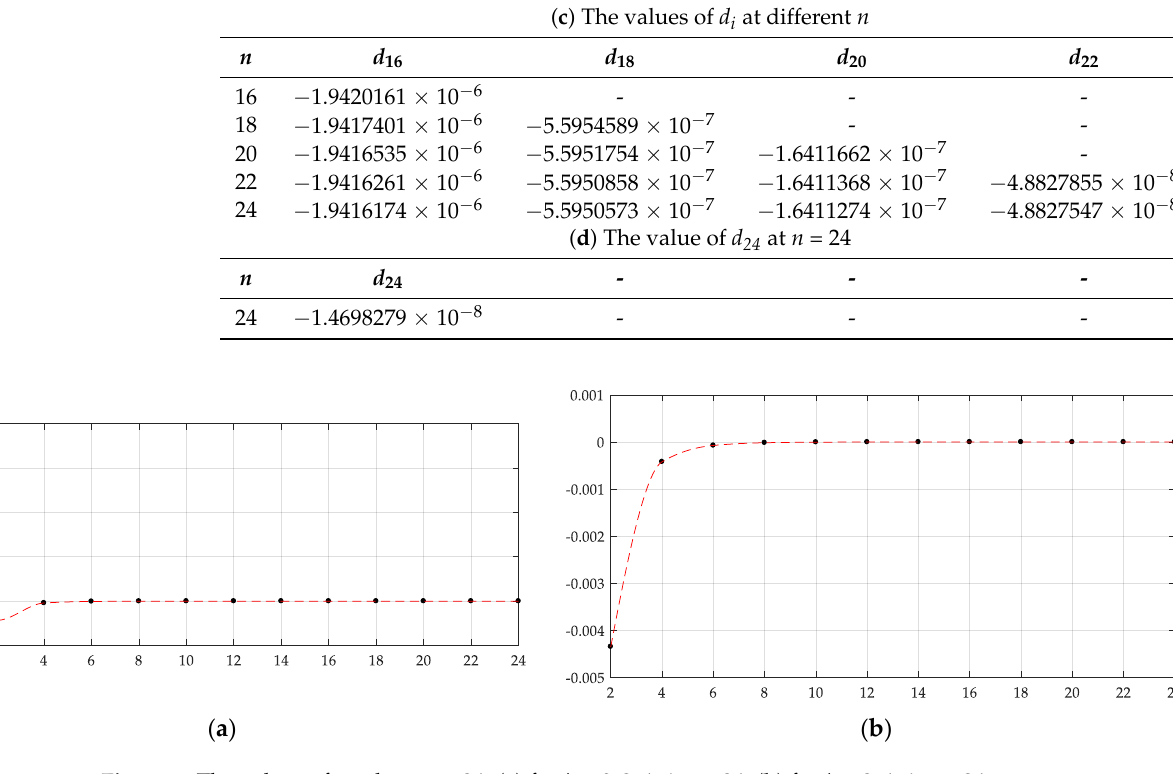
c when c when i i